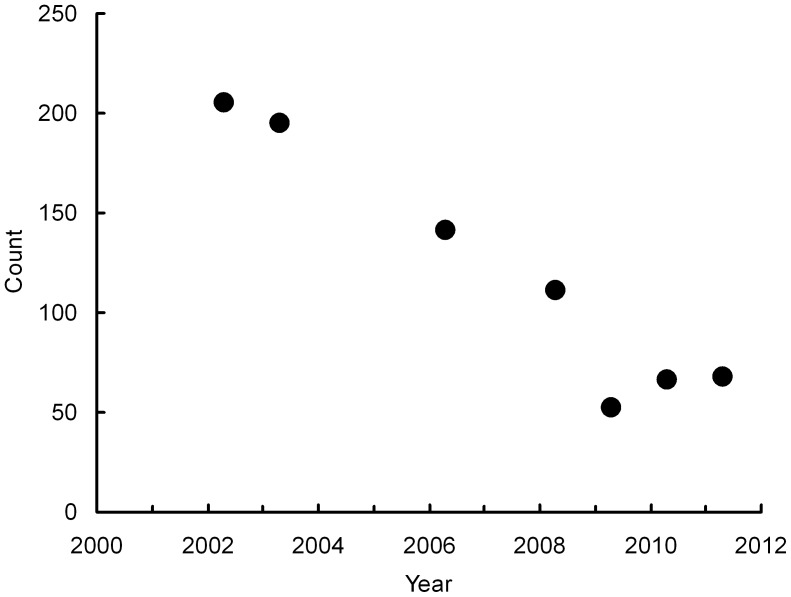
Counts of Gyps bengalensis on a road transect through western Nepal.